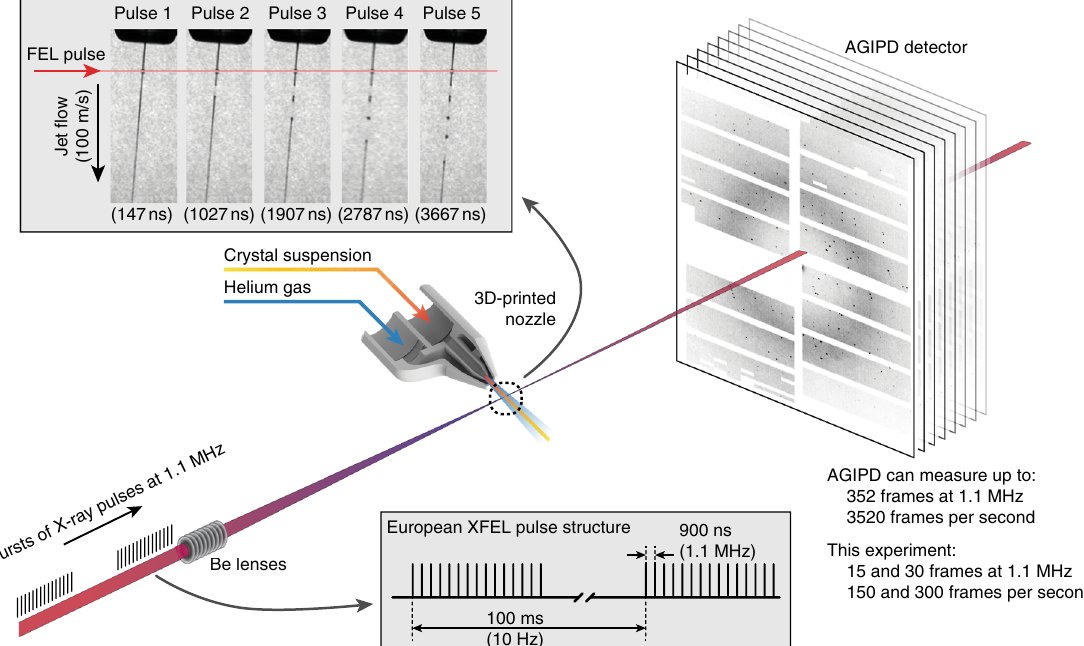
Fig. 1 Megahertz serial crystallography. Pulses from the European XFEL were focused on the interaction region using a set of Beryllium lenses. Protein crystals in crystallization solution were introduced into the focused XFEL beam using a liquid jet of 1.8 µ m diameter moving at speeds between 50 m/s and 100 m/s. Diffraction from the sample was measured using an AGIPD, which is capable of measuring up to 3520 pulses per second at megahertz frame rates. In-situ jet imaging (inset) showed that the liquid column does explode under the X-ray illumination conditions of this experiment using a jet with a speed of 100 m/s, but that the liquid jet recovered in less than 1 μ s to deliver fresh sample in time for arrival of the next X-ray pulse. Images and movies of jets at different speeds are included in the supplementary